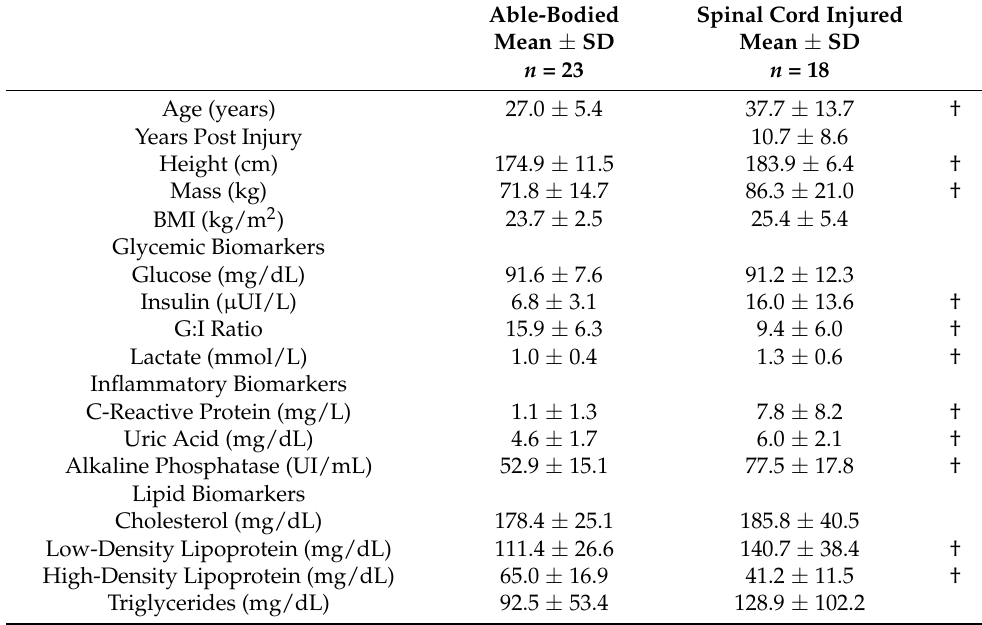
Table 1. Baseline demographics and blood